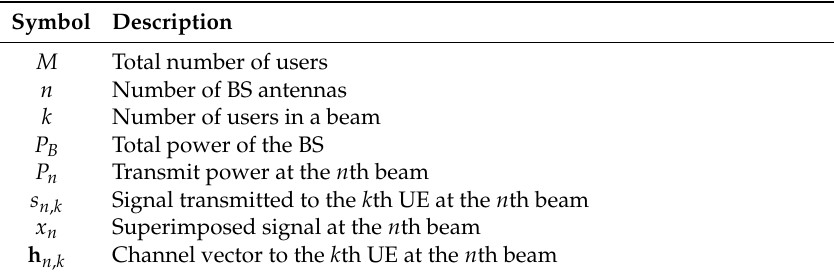
Table 1. Symbols and